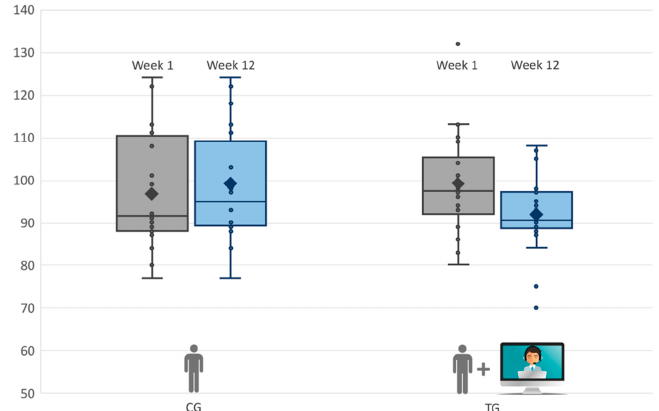
Figure 2. Box-plot of postphase III gains for Control Group (CG) and Tele-assisted Group (TG) in the Parental Stress Index/Short Form (PSI/SF) Test.